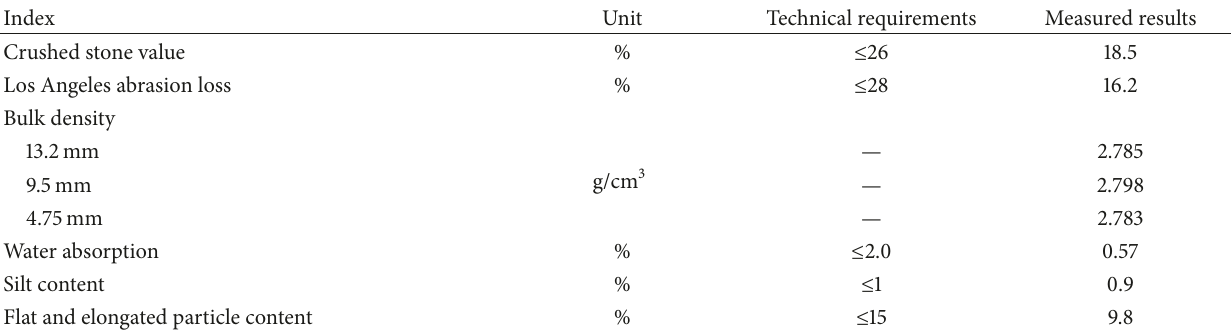
Table 1: Aggregate properties.